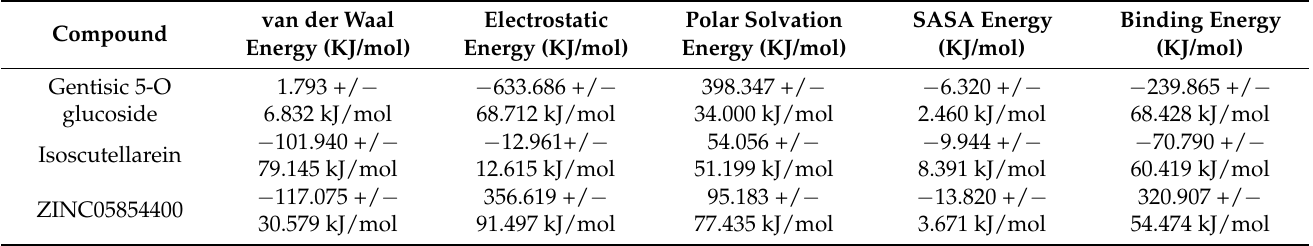
Table 6. Energy terms of the CGS–ligand complexes from MM-PBSA calculation. The values are presented in average ± standard deviations in kJ/mol.